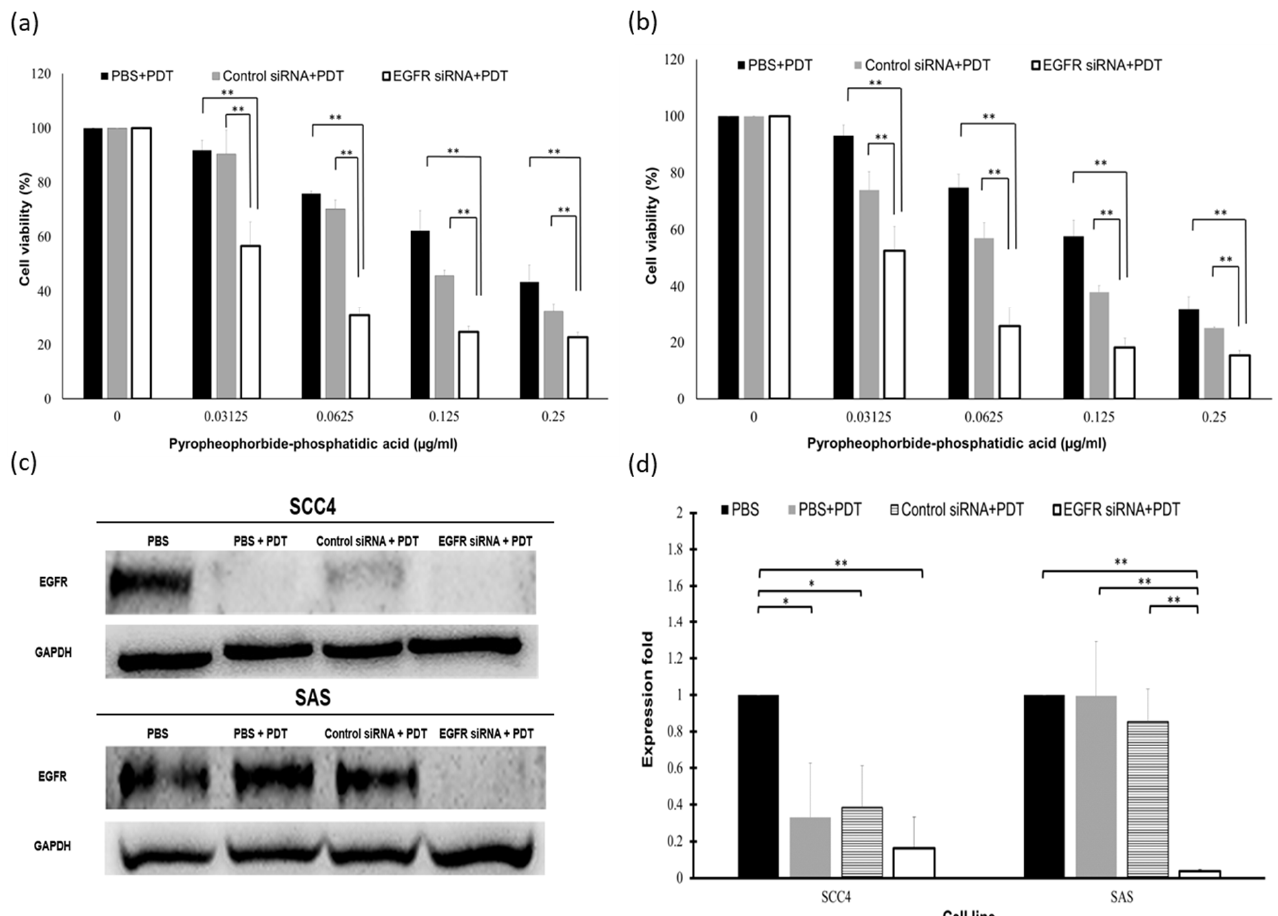
Figure 4. In vitro study of combined therapy. Combined therapy of EGFR siRNA or Control siRNA and photodynamic therapy (PDT) with different concentrations of Photosan photosensitizers in SCC4 ( a ) or SAS ( b ) cell lines. ( c , d ) Western blots of EGFR protein level in siRNA treated SCC4 and SAS cells. Columns, mean ( n = 3); * stands for p < 0.05 compared to PBS group. ** stands for p < 0.01 compared to PBS group.